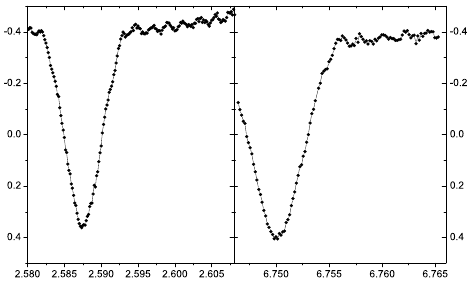
Figure 2: Eclipse profiles of NY Vir observed in November 2012 and April 2013 with the 2.15-m ”Jorge Sahade” telescope. Dots represent the magnitude dif- ferences between the NY Vir and the comparison star. a rapid pulsator and an M 5 -type star. Kilkenny et al., (2011) found the orbital period of the binary is decreasing at a rate of ˙ P = − 11 . 2 × 10 − 13 d